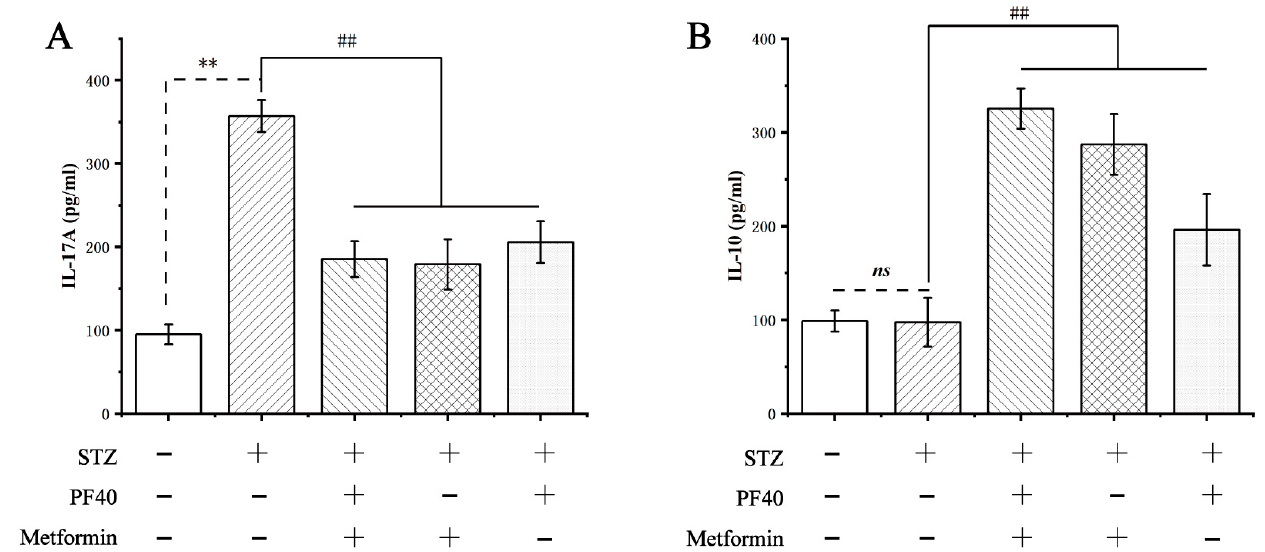
Figure 13. Effects of PF40 on the levels of ( A ) IL-17A and ( B ) IL-10 in T2DM rats. Data are presented as the M ± SD ( n = 9 per group). ** p < 0.01, ns , non-significant difference, compared with normal group; ## p < 0.01, compared with model